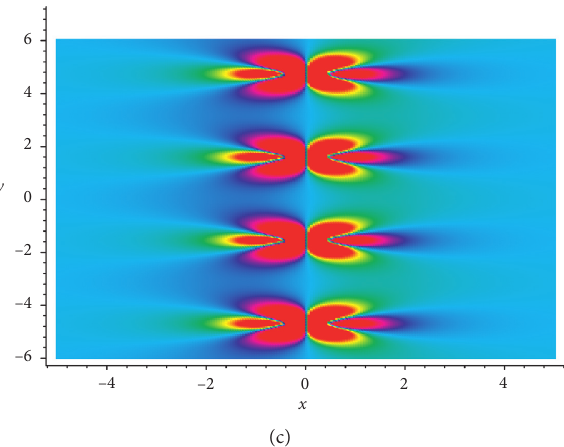
Figure 3: The density plot of the y -periodic symmetry breaking breathers of the AB-KP systems (7a) and (7b), with the selected parameters � b � 0 and (b) and (c) b b and b are (a) b 1 2 1 2